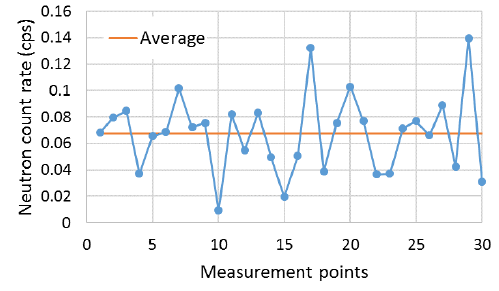
Figure 18. Neutron background count rate (cps) in the vicinity of the shipping container.